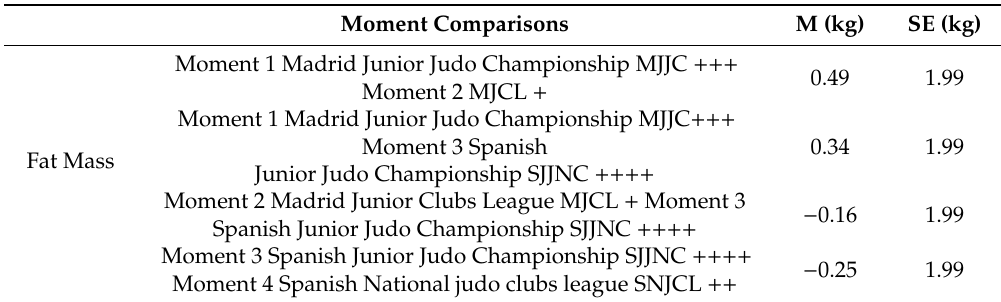
Table 9. Mean di ff erence M standard deviation ± SD and range comparing the di ff erent moments in the fat mass variable (kg).